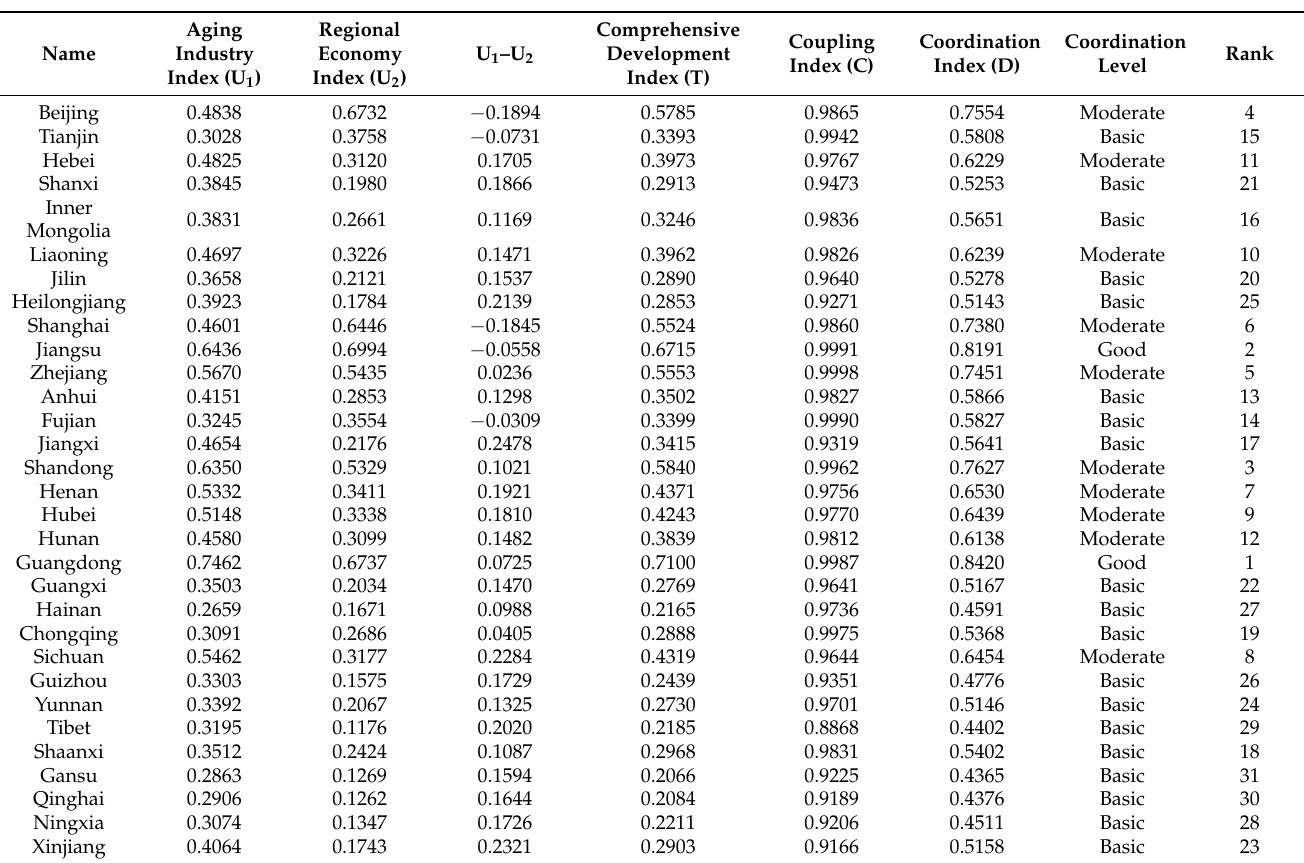
Figure 6. Coordination index of the aging industry and regional economy. Table 3. Mean analysis table of the coupling coordination index between the aging industry and the regional economy